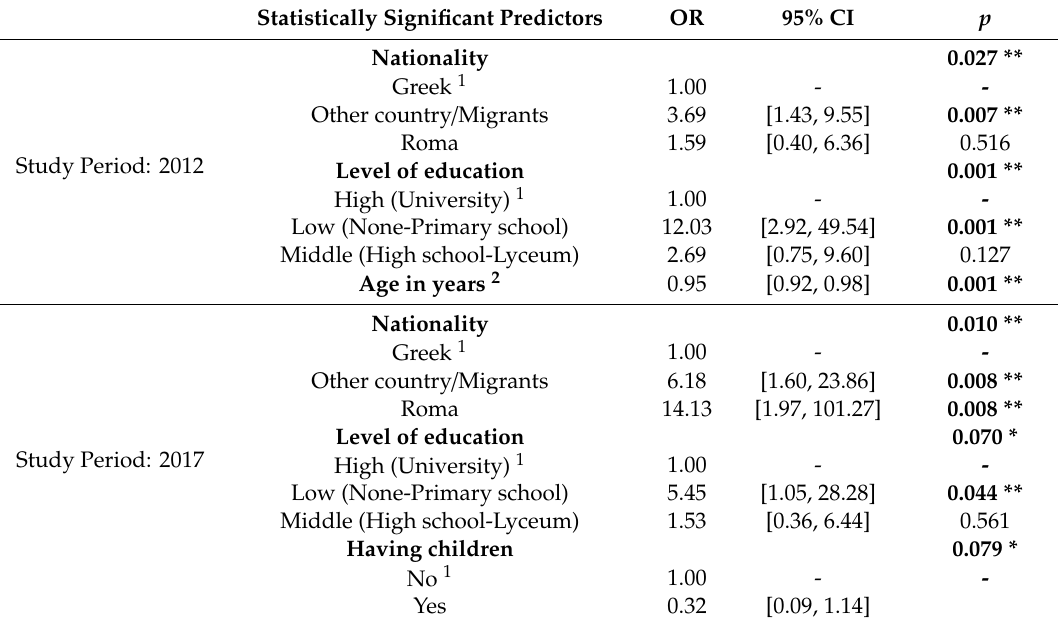
The final models presented in the table are based on the backward selection procedure. After testing the women’s characteristics presented in Table 2, only those with p -value less than 0.10 were kept in the final models. 1 Baseline category for each characteristic. 2 Odds Ratio refers to one unit change in participants’ age. CI = Confidence Interval and OR = Odds Ratio (** p < 0.05, * p < 0.10). Statistically significant values are marked in